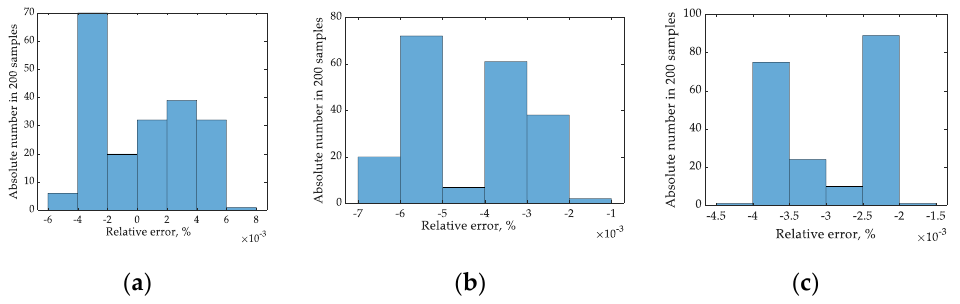
Figure 5. Histograms of a relative RMS estimation error for sampling time 5 ms ( a ), 7 ms ( b ), and 9 ms ( c ).